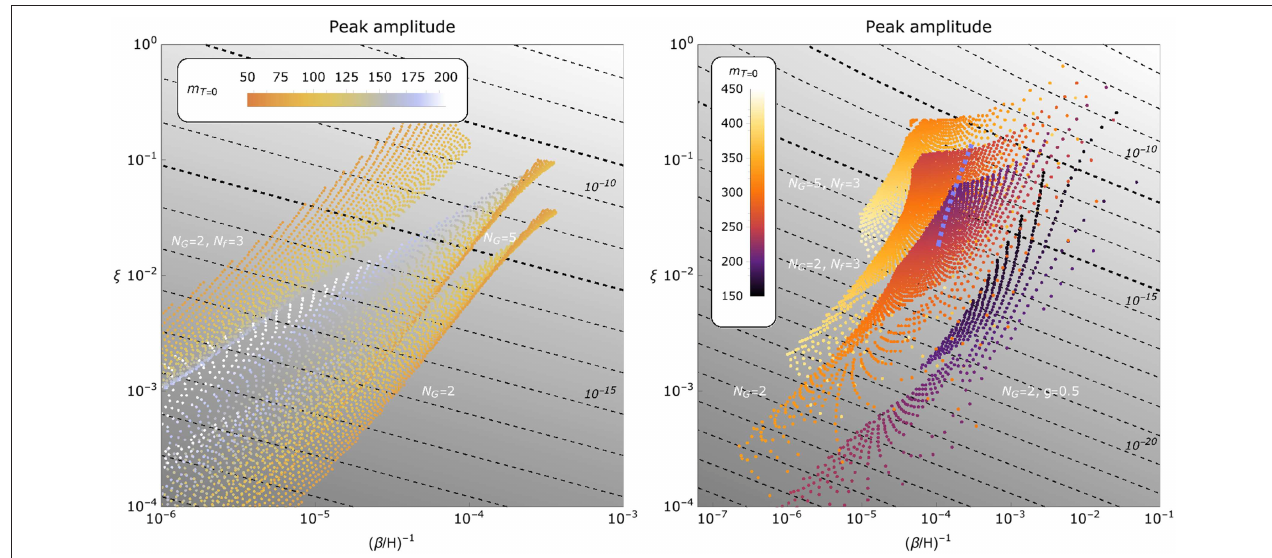
FIGURE 8 | Thermal parameters from a renormalizable potential for a scalar field in the fundamental representation of SU ( N G ) which gets broken to SU ( N G 1) (left) . − Right panel is the same aside from the inclusion of a non-renormalizable sextet term in the potential and the gauge coupling constant is fixed to unity. In the above N G denotes the order of the group, N f is the number of fermions in the fundamental representation that are strongly coupled to the scalar field, in direct analogy with the SM save that the Yukawa couplings are set to unity. Note that ξ is the ratio of latent heat to radiation energy density more commonly denoted α . Contours of constant peak amplitude for the sound wave spectrum are shown with the darker line corresponding to LISA sensitivity range for a power law spectrum that has been integrated over frequency [ 341]. Note in the above v w 0.5 for the left plot and v w 1 for the right plot using the efficiency terms in Espinosa et al. [342]. Figure = = taken from Croon et al. [